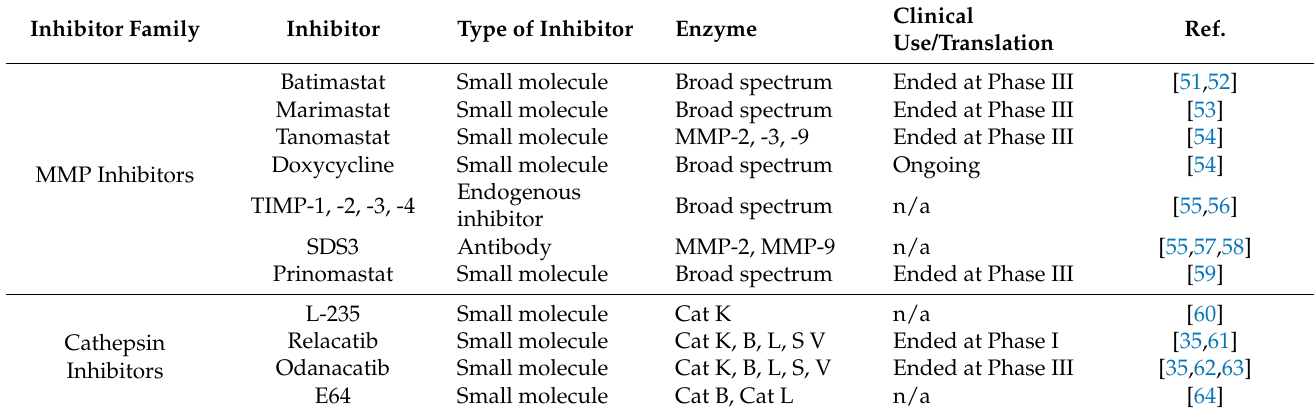
Table 2. Inhibitors of extracellular matrix